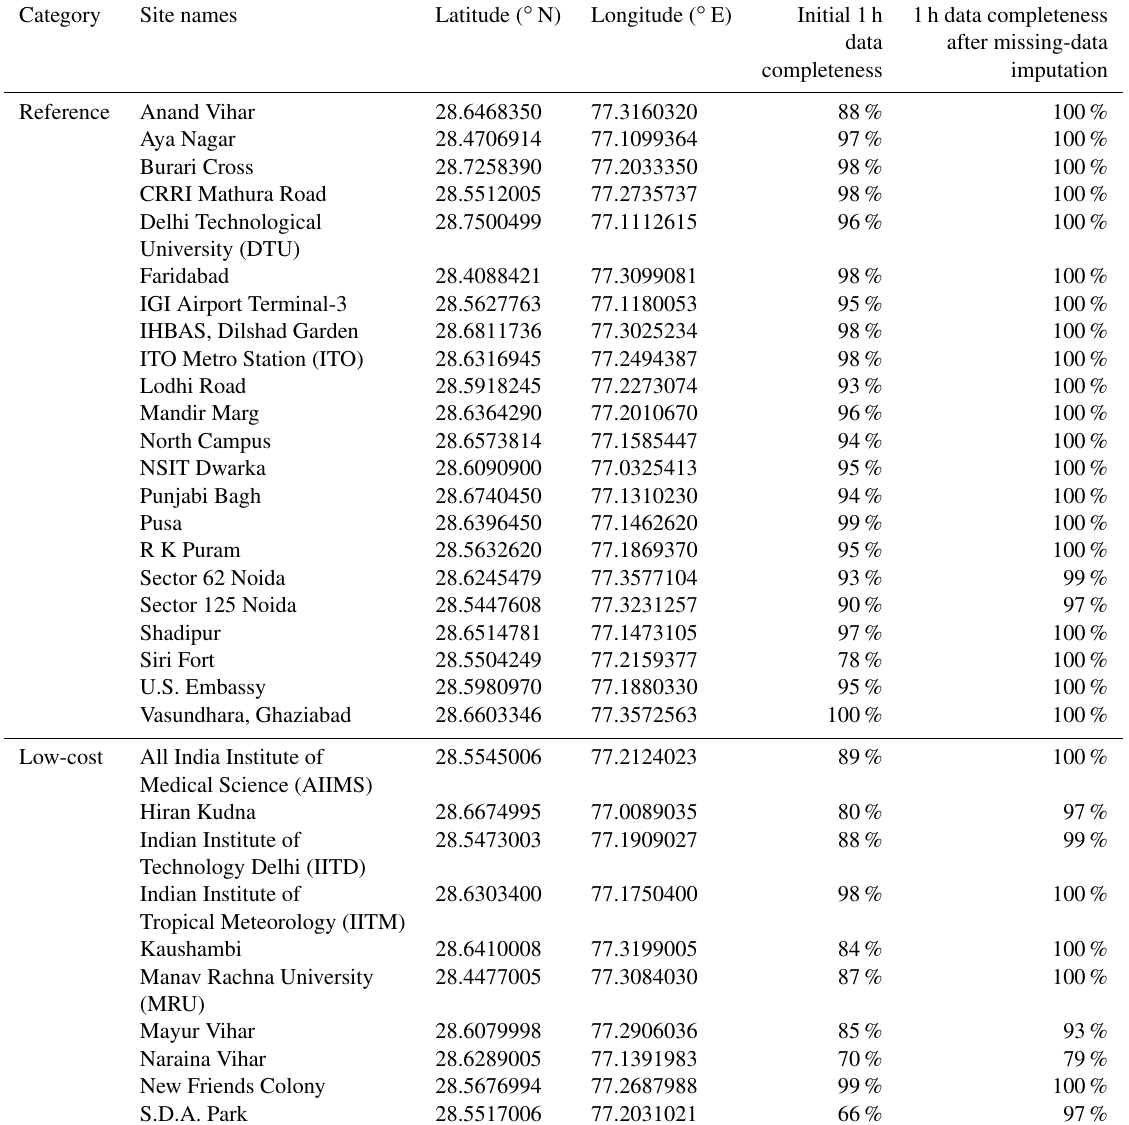
Table 1. Delhi PM sensor network sites along with the 1h percentage data completeness with respect to the entire sampling period (i.e., from 1 January 00:00 to 31 March 2018 23:59, Indian standard time, IST; in total 90d, 2160h) before and after 1h missing-data imputation for each individual site. Note that a 10% increase in the percentage data completeness after 1h missing-data imputation is equivalent to ∼ 216h of 1h data being